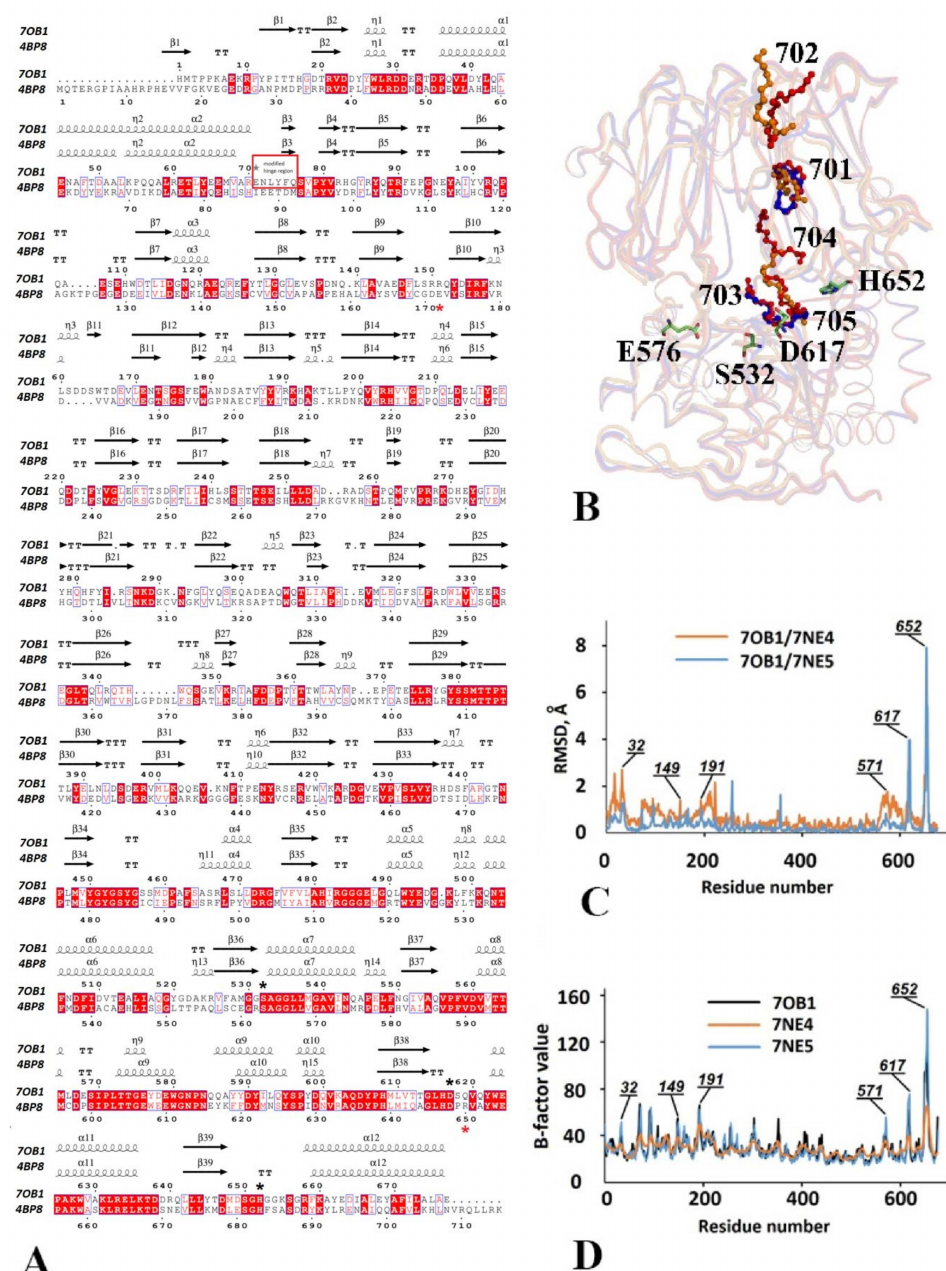
Figure 2. Overview of the crystal structures of PSPmod and its derivatives. ( A ) Multiple sequence and structural alignment of PSPmod (7OB1) and TbOpB (4BP8). The alignment was generated with ESPript (http://espript.ibcp.fr; accessed on 5 September 2021). Highly conserved residues are highlighted in red; semi-conserved ones are colored red. Catalytic triad and S1 substrate-binding site residues are marked with black asterisks; the interdomain salt bridge SB1 of TbOpB is marked with red asterisks; the modified hinge region is in red squire. Secondary structure elements are shown above the alignment. ( B ) Superposition of PSPmod (PDB ID 7OB1, in red), PSPmodE125A (PDB ID 7NE4, in orange) PSPmodS532A (PDB ID 7NE5, in blue) with spermines in the interdomains cavities. The spermine molecules are shown in ball and sticks and numbered according to the PSPmod structure (PDB 7OB1). The catalytic triad and S1 substrate-binding center residues of PSPmod are shown as green sticks. ( C ) Distributions of RMSD values along the PSP sequence. RMSD values were calculated upon Ca-atom superpositions of PSPmodE125A (PDB ID 7NE4) and PSPmodS532A (PDB ID 7NE5) over PSPmod (PDB 7OB1). ( D ) Distributions of the residual B-factors of the three crystal structures along the PSP sequence. Residues with the highest values of both RMSD and B-factor are shown in ( C , D